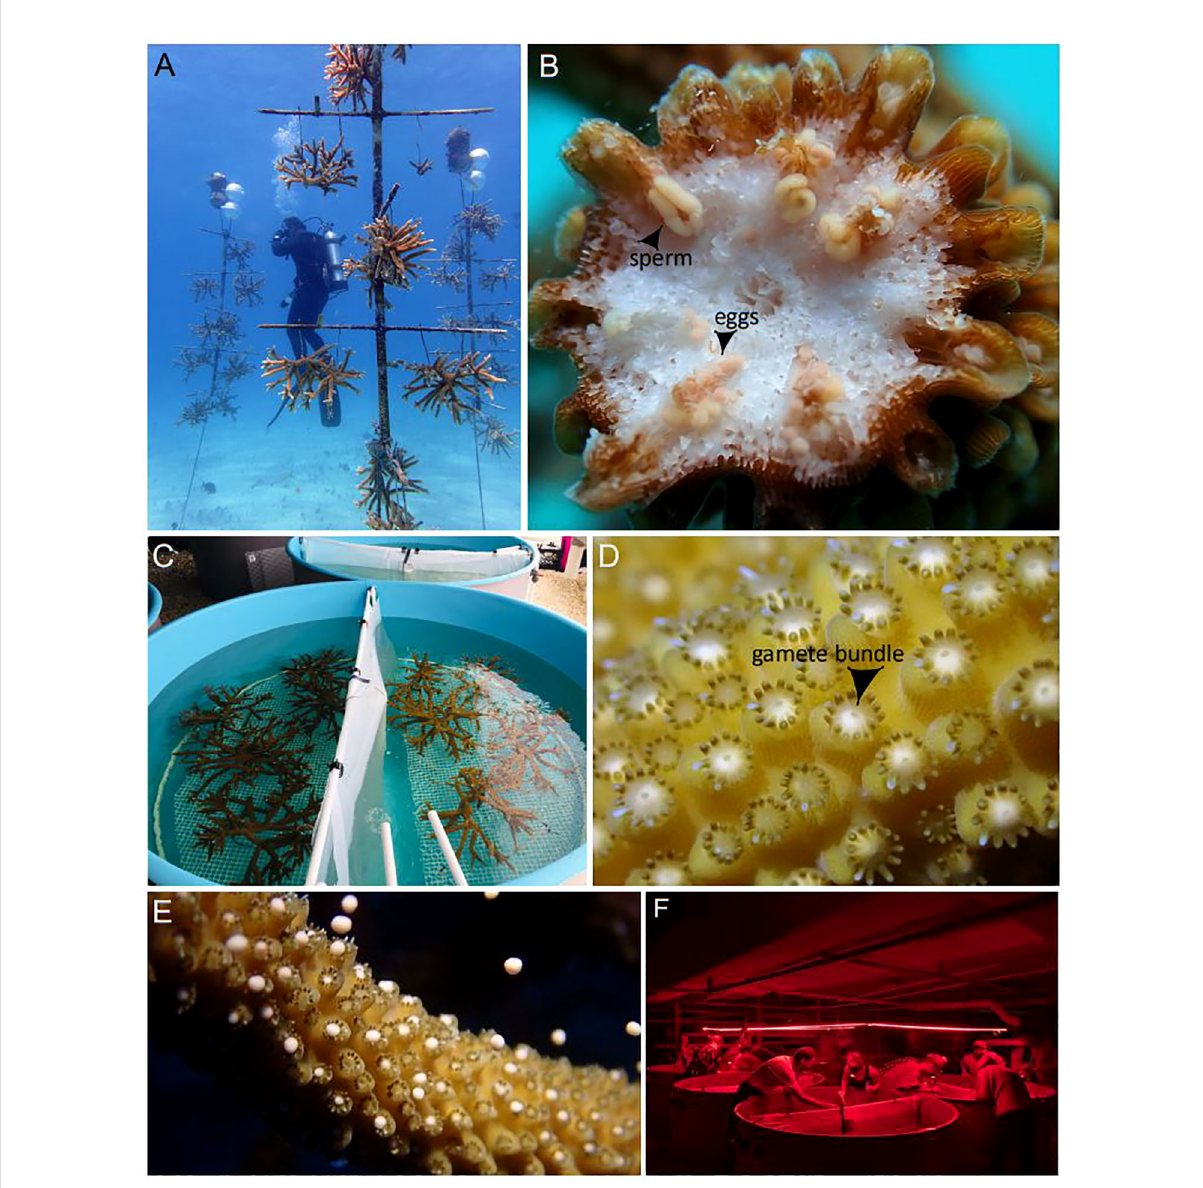
FIGURE 1 Assisted sexual reproduction of A . cervicornis . (A) Offshore coral spawning nursery; each coral tree holds replicate colonies of a single genet. (B) Sexual maturity assessment; in the weeks preceding the predicted annual reproduction event, corals were sampled to con fi rm they were gravid (i.e., contain eggs (pink-orange spheres) and sperm (cream-colored packets)). (C) Ex-situ spawning setup; a few days before the full moon, corals were transferred from the in-situ nursery to the laboratory where they were held in large outdoor mesocosms that had access to sunset and lunar cues. (D) Coral setting; gamete bundles appeared in the polyps ’ mouths indicating spawning was imminent. (E) Coral spawning; buoyant gamete bundles fl oat to the surface. (F) Gamete bundle collection; bundles were collected using red lights to prevent light pollution from disrupting spawning. Source: (A) Sarah Hamlyn; (B-E) Hanna Koch; (F) Haley